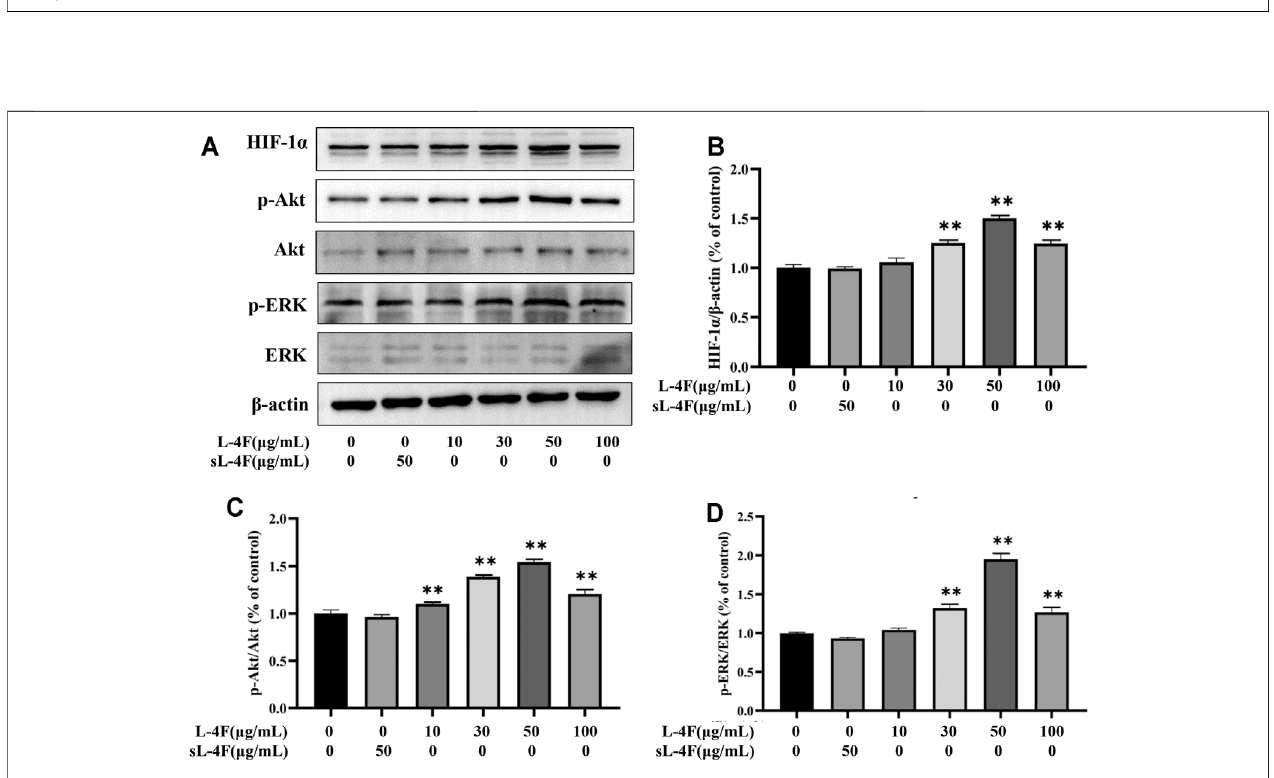
FIGURE6|(A) RepresentativeWesternblotimages.L-4FatdifferentconcentrationsupregulatesproteinlevelsofHIF-1 α (B) ,p-Akt (C) ,andp-ERK (D) inHUVECs. Cells weretreatedwithL-4F at 0,10, 30,50, and 100 μ g/ml, respectively, or sL-4F at50 μ g/ml for30 min, n (cid:1) 3,one-wayANOVA, Dunnett ’ stest, * p < 0.05, ** p < 0.01, compared with